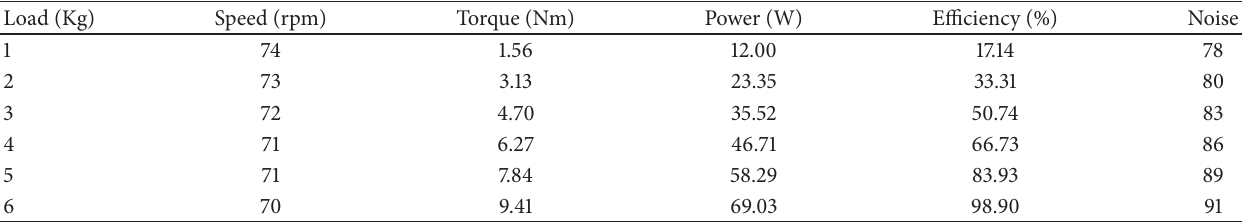
Figure 5: (a) Angle of Indexing, (b) gear arrangement without phasing, and (c) gear arrangement with phasing (normal gears). Table 14: Observations without phasing